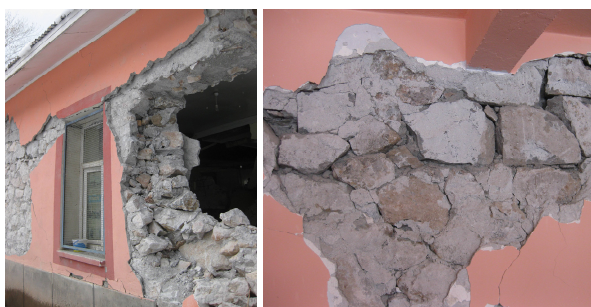
Fig. 6. Profile of a poorly constructed damaged wall.